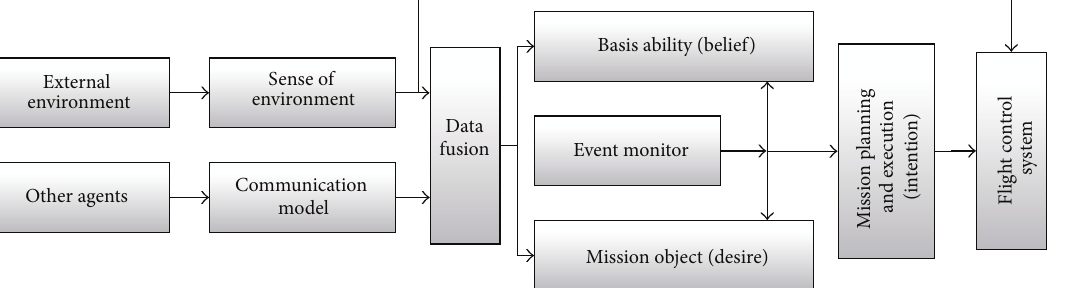
Figure 4: Structure of the hybrid system.